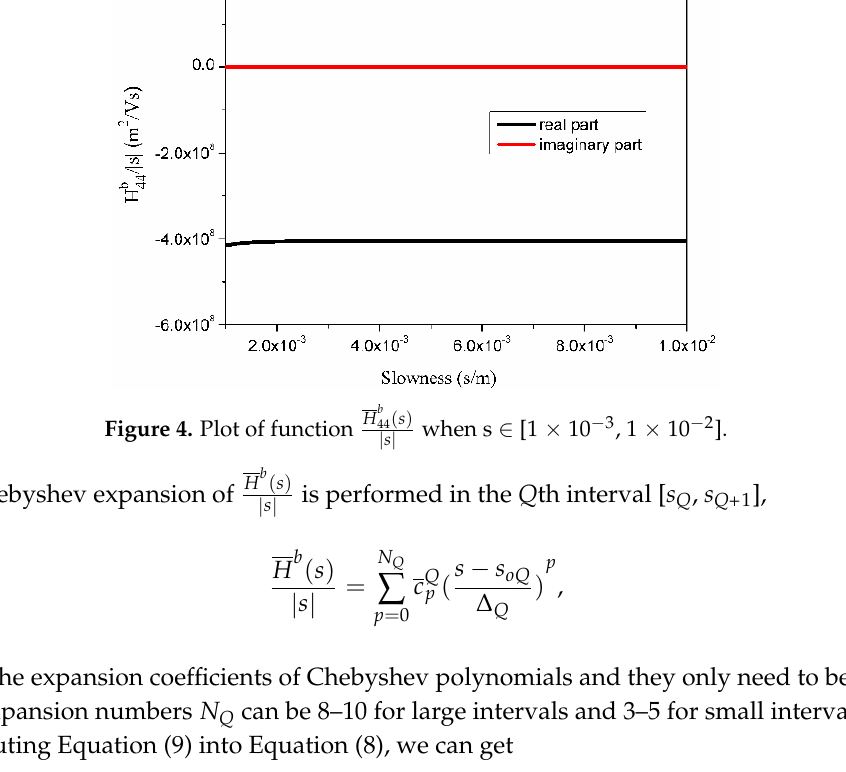
( ) b H s 44 s when s ∈ [0, 1 × 10 − 3 ].